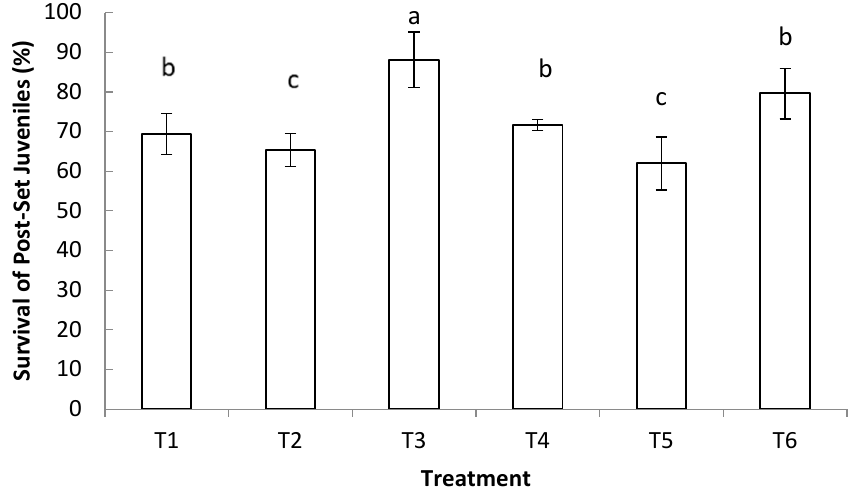
Figure 3. Survival of post-set sunray venus clams ( Macrocallista nimbosa ) fed various live microalgal species combinations. Different letters indicate significant differences among the treatments (one-way ANOVA, α = 0.05, a > b > c). Each bar represents the mean ± SD of three replicates.